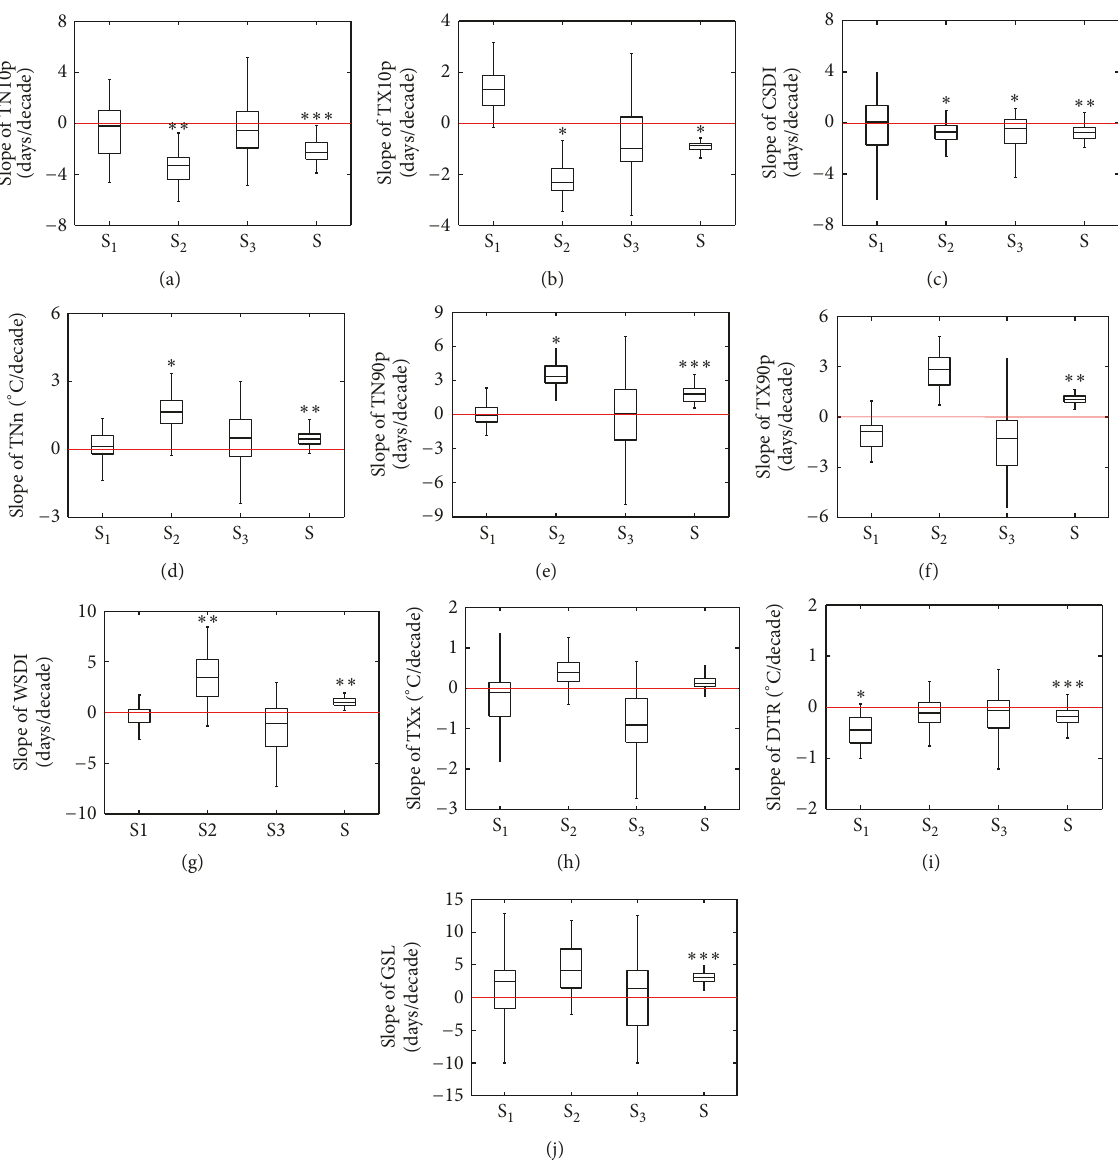
Figure 7: Box-Plot of Slopes for extreme temperature indices across the BTSSR in different stages. (a) TN10p, (b) TX10p, (c) CSDI, (d) TNn, (e) TN90p, (f) TX90p, (g) WSDI, (h) TXx, (i) DTR, and (j) GSL. S 1 is 1960–1978, S 2 is 1979–2000, S 3 is 2000–2014, and S is 1960–2014. ∗ ∗ ∗ is 0.001 level of significance, ∗∗ is 0.01 level of significance, and ∗ is 0.05 level of significance.